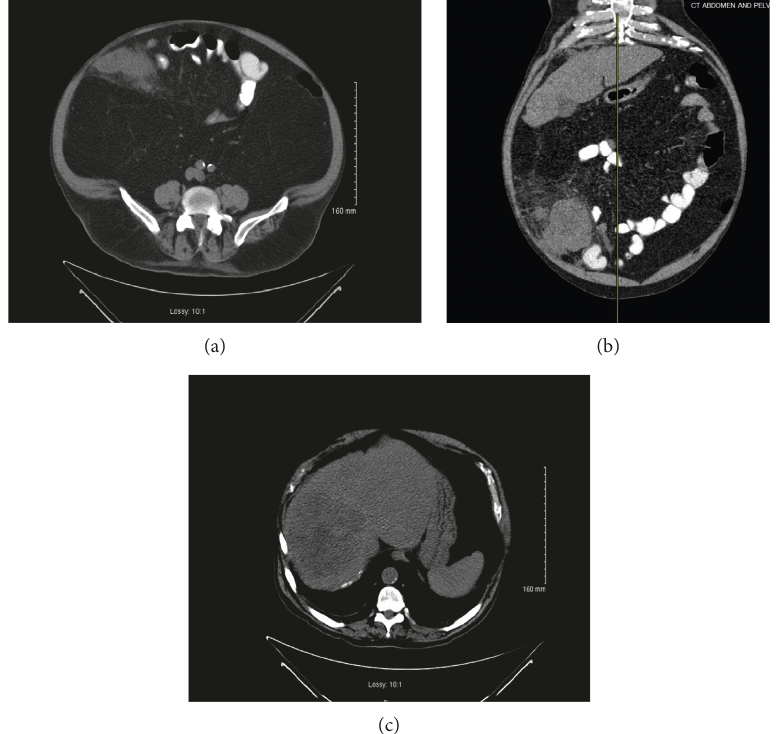
Figure 3: CT scan of the abdomen and pelvis. (a) Axial view of the large tumor in the cecum. (b) Coronal view of the tumor with surrounding inflammatory changes. (c) Large lesion in the right lobe of the liver also seen on CT scan suggestive of metastatic